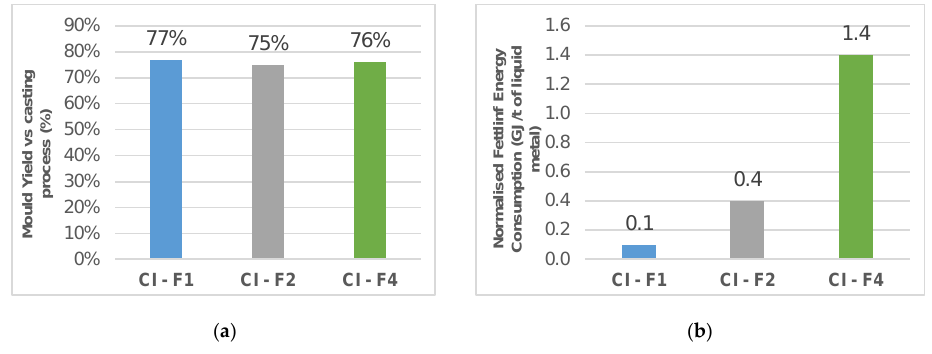
Figure 11. Fettling process: ( a ) mold yield in different casting processes; ( b ) fettling energy consumption.